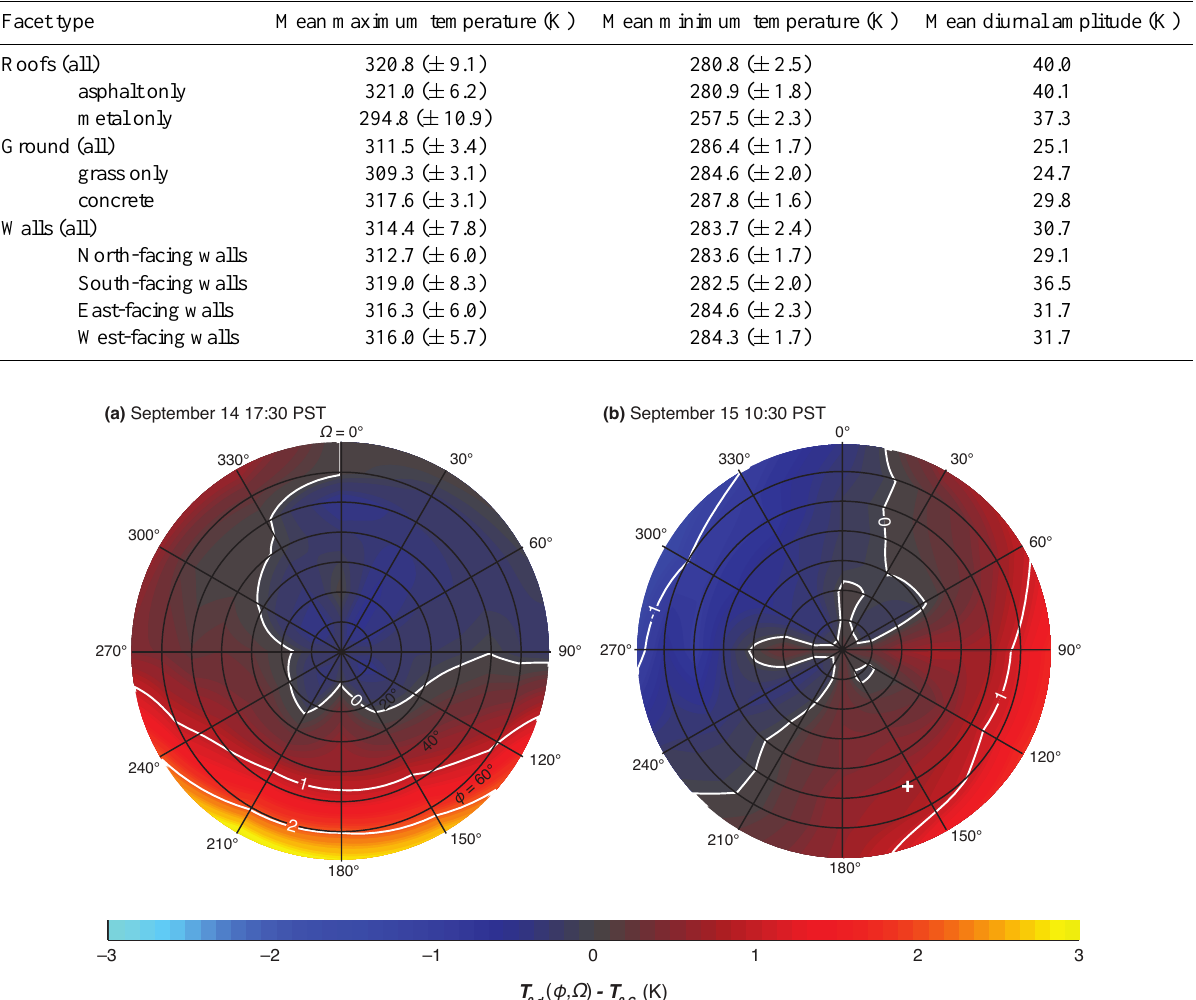
Table 3. Summarized area-weighted mean maximum and minimum surface temperatures with calculated mean diurnal amplitude for canyon materials, divided by facet type and orientation. Values in brackets show standard deviations.